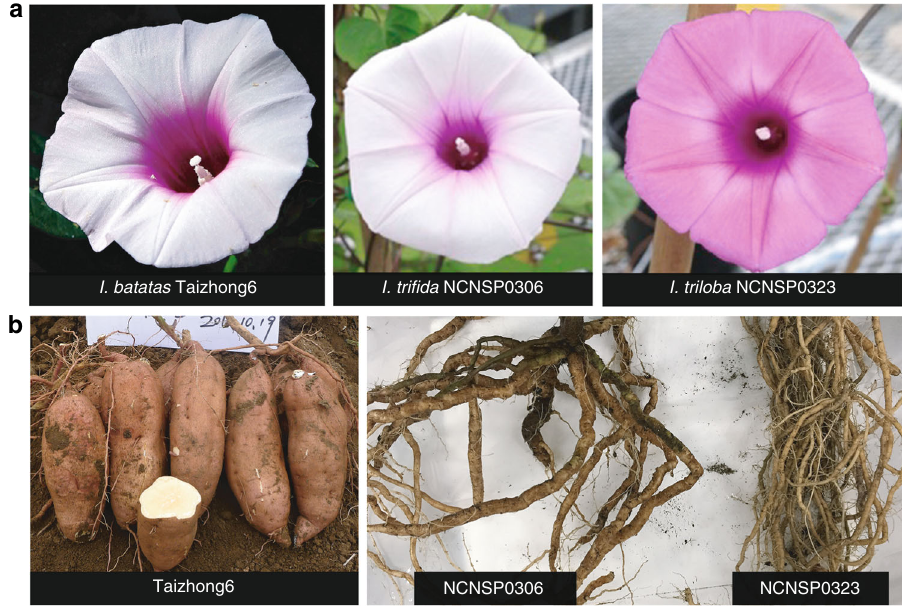
Fig. 1 Morphology of Ipomoea batatas , I. tri fi da , and I. triloba . a , b Flowers ( a ) and roots ( b ) of I. batatas “ Taizhong6 ” , I. tri fi da NCNSP0306, and I.